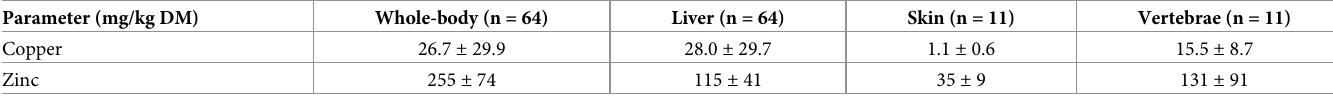
Table 6. Copper and zinc contents (mg/kg DM) in different body parts of snakes (means ± SD; n = number of samples). Parameter (mg/kg DM)